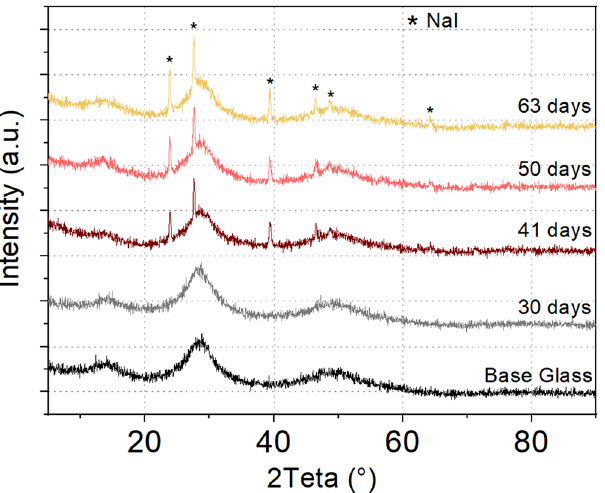
Figure 4. RX Diffractogram of the (72 GeSe 2 –28 Ga 2 Se 3 ) 75 (NaI) 25 glass before immersion and after 30, 41, 50 and 63 days of immersion in the 60 KNO 3 / 40 NaNO 3 bath.